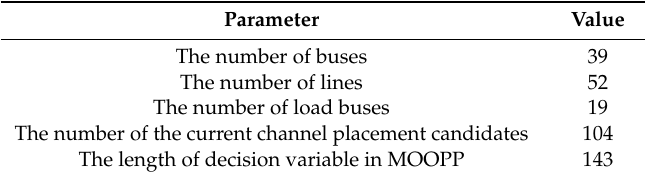
Table 1. Numerical information of the modified New England 39-bus test system (NE 39-bus).